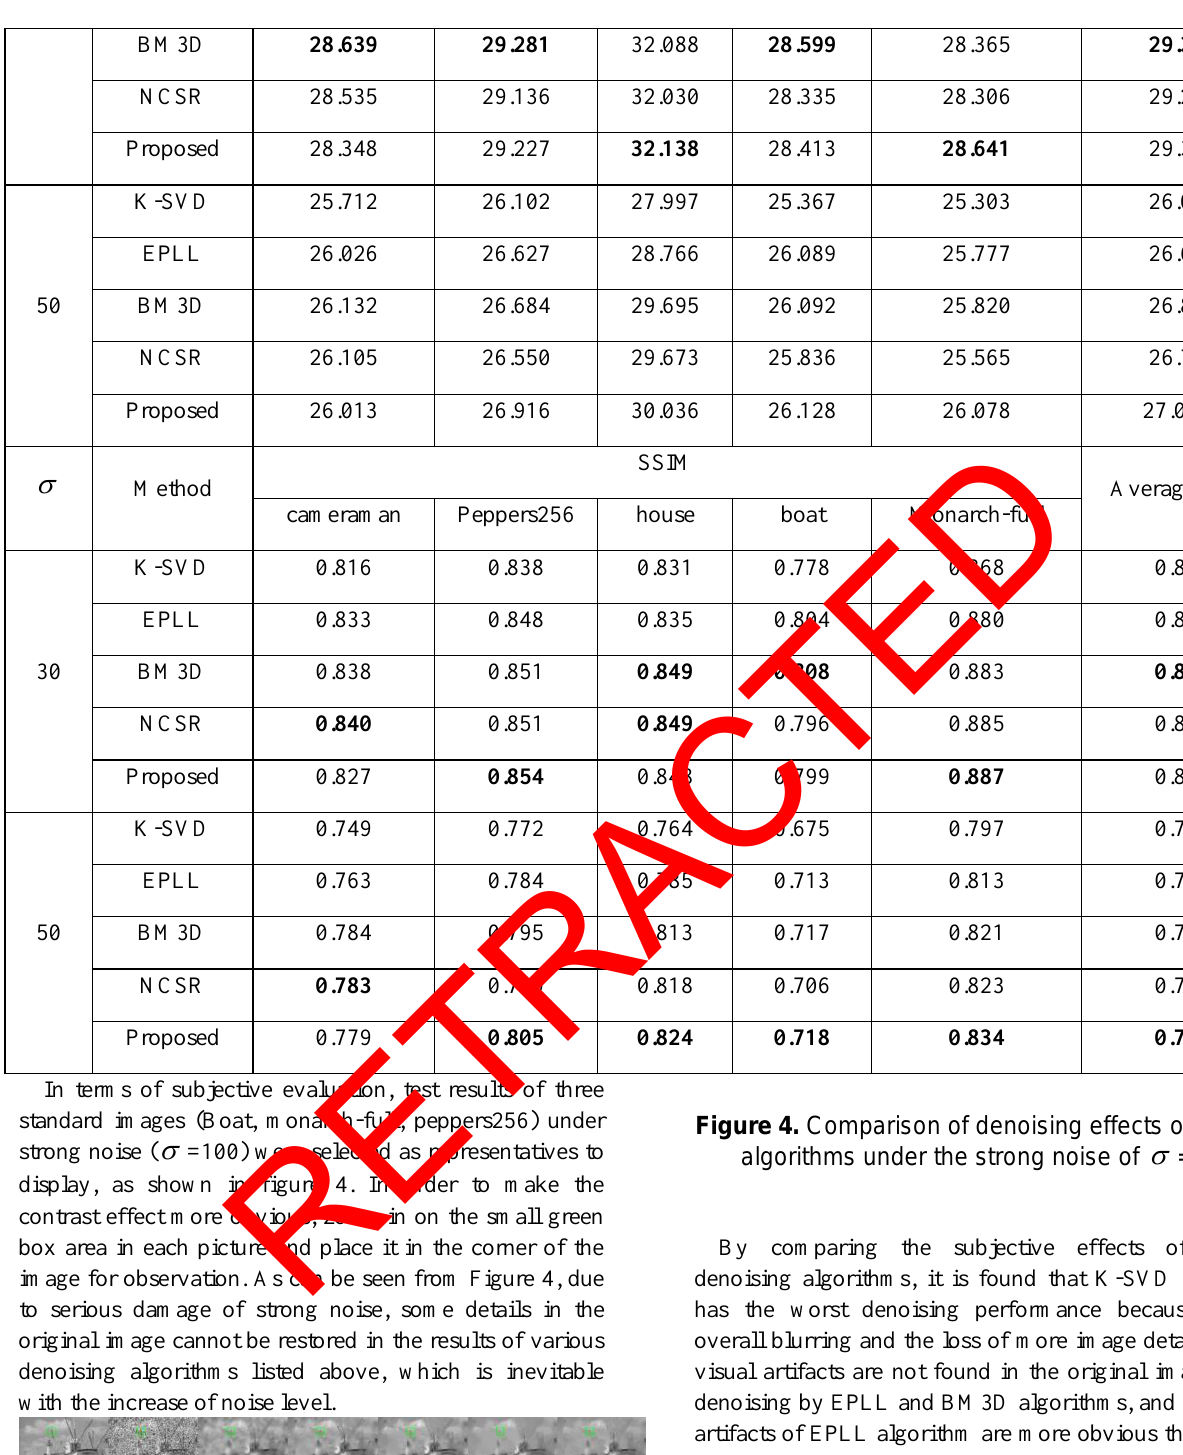
By comparing the subjective effects of several denoising algorithms, it is found that K-SVD algorithm has the worst denoising performance because of the overall blurring and the loss of more image details. Some visual artifacts are not found in the original images after denoising by EPLL and BM3D algorithms, and the visual artifacts of EPLL algorithm are more obvious than that of BM3D algorithm. NCSR algorithm has a smooth phenomenon on the whole, so part of the detailed texture information is lost. At the same time the algorithm on the edge of the image of a part of the texture region will appear obvious Mosaic plaque, this is because all areas in an image using NCSR algorithm based on block matching window, the window has restricted its on the edge of the part of the texture region matching to the similar block similar to denoising center piece is not enough, caused